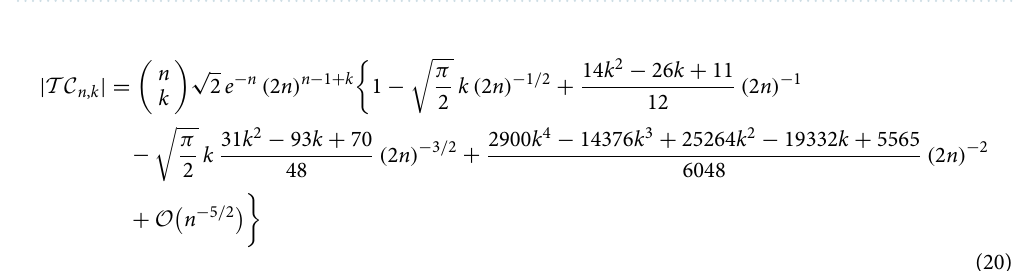
Figure 7. Plots of the evolution computed with regards to the exact value as Deviation